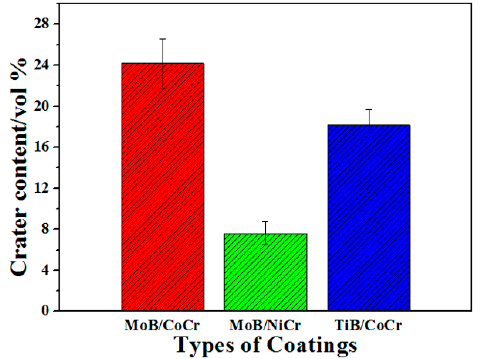
Figure 19. The average crater content of the worn-out surface of the coatings.